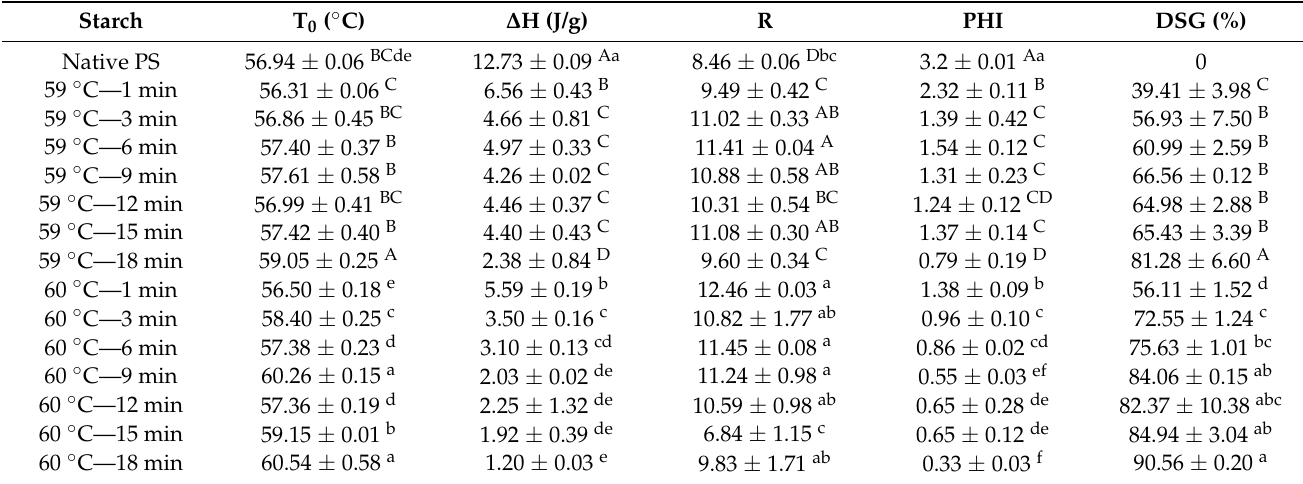
Table 1. DSC parameters of native and partially gelatinized starch samples.